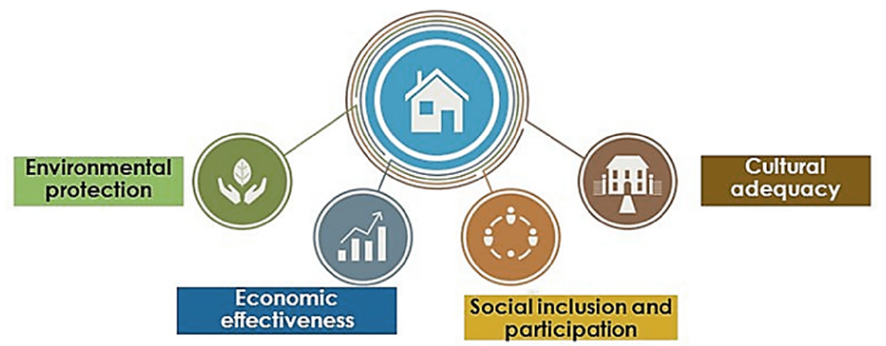
Figure 3. The Geneva UN Charter on Sustainable Housing. Reprinted from [6].